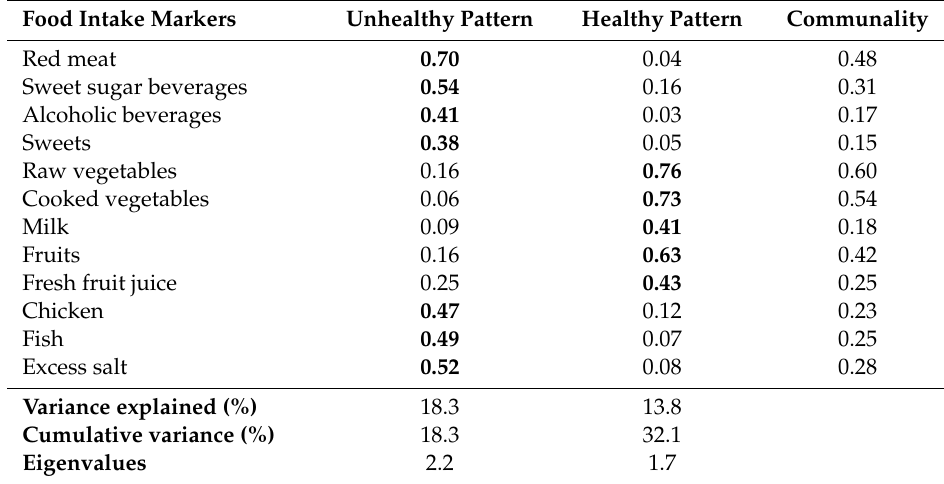
Table 4. Factor loadings of food intake markers present in the dietary patterns identified among individuals with CKD from the Brazilian NHS, 2013 ( n =